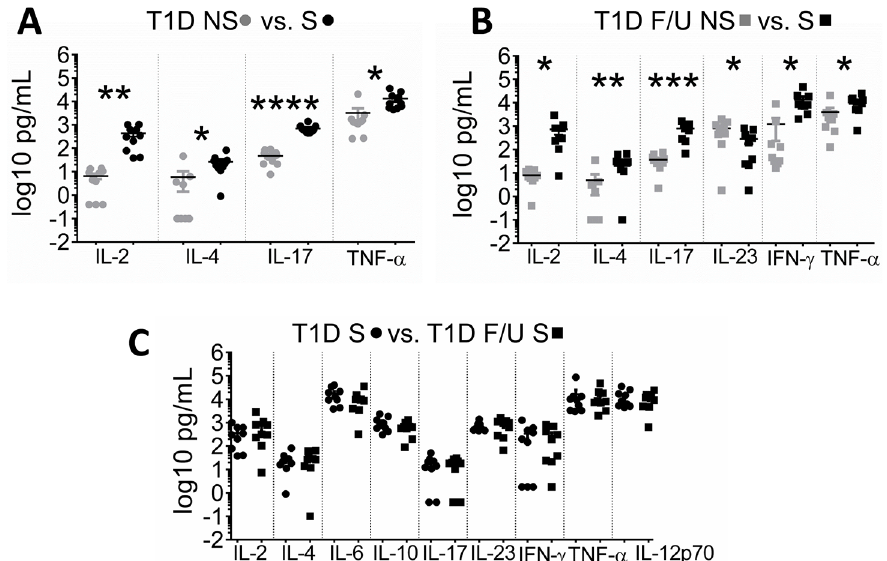
Fig 3. Cytokine production is not increased in T1D compared to T1D follow up. Cells were cultured for 24 h with and without stimulationwith anti CD3/CD28, the supernatant collectedand assayed by multiplex cytokineELISA. Data were log-transformed to obtain normal distributions. A. T1D NS (grey circles) vs S (black circles) Cytokines that showed statistically significantdifferent in T1D betweenunstimulated and stimulatedPBMCs. B. T1D F/U NS (grey circles) vs S (black circles) Cytokineconcentration in PBMCs from T1D Follow up. C. T1D S (black circles) vs T1D F/U S (black squares) Comparisonof cytokine expressionon stimulatedPBMCs from subjects with T1D and T1D Follow up. ( * indicate p < 0.05).